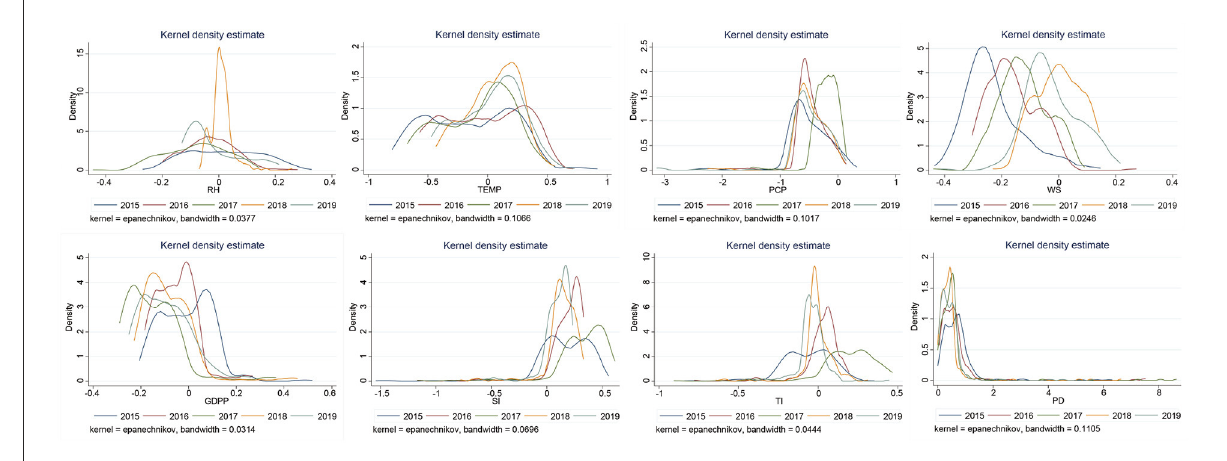
FIGURE7 Kernel density distribution of each variable coefficient in different year.